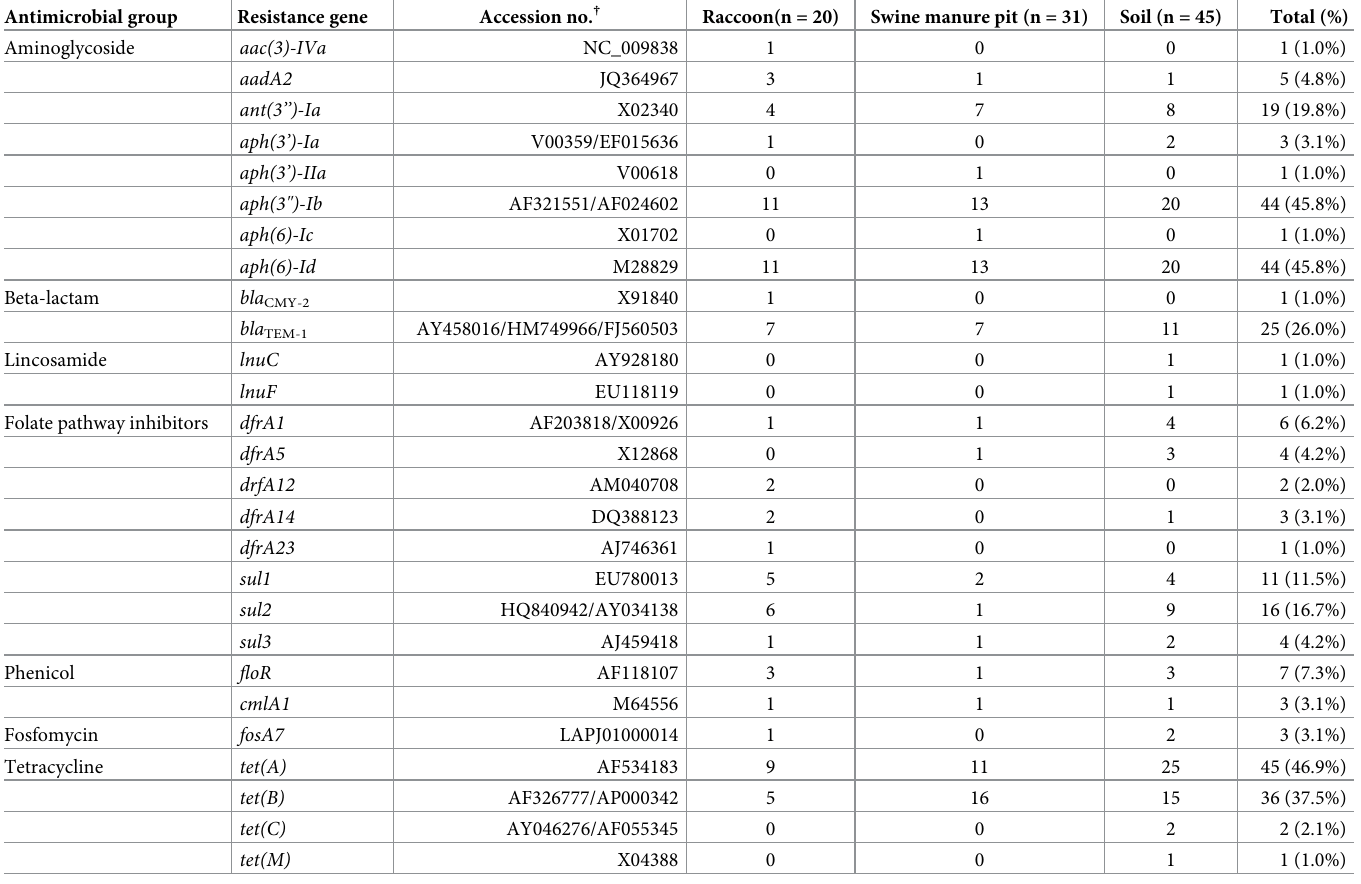
Table 4. Frequencies of acquired antimicrobial resistance genes identified using whole-genome sequencing data from phenotypically resistant Escherichia coli iso- lates obtained from raccoons, swine manure pits, and soil samples on swine farms in southern Ontario, Canada 2011–2013 (n = 96). Antimicrobial